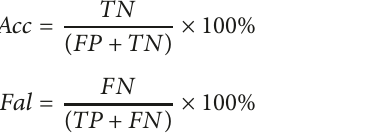
Figure 13: Outlier detection results by EEMD for simulated data. In order to calculate the accuracy of three algorithms for outlier detection, the number of normal data is distinguished into normal data labeled as TP, the number of abnormal data is distinguished into normal data labeled as FP, the number of normal data is distinguished into abnormal data labeled as FN, and the number of abnormal data is distinguished into abnormal data labeled as TN. The calculation methods for the detection rate Acc(Accuracy) and the error rate Fal(False) of the abnormal data are shown by the following